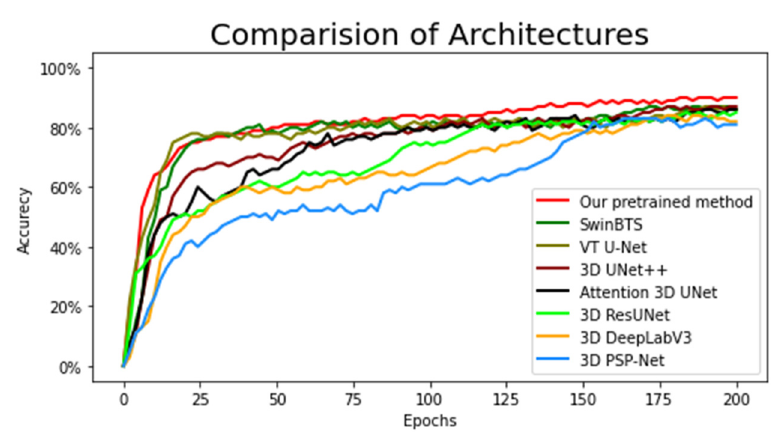
Figure 7. Comparison of selected architectures.